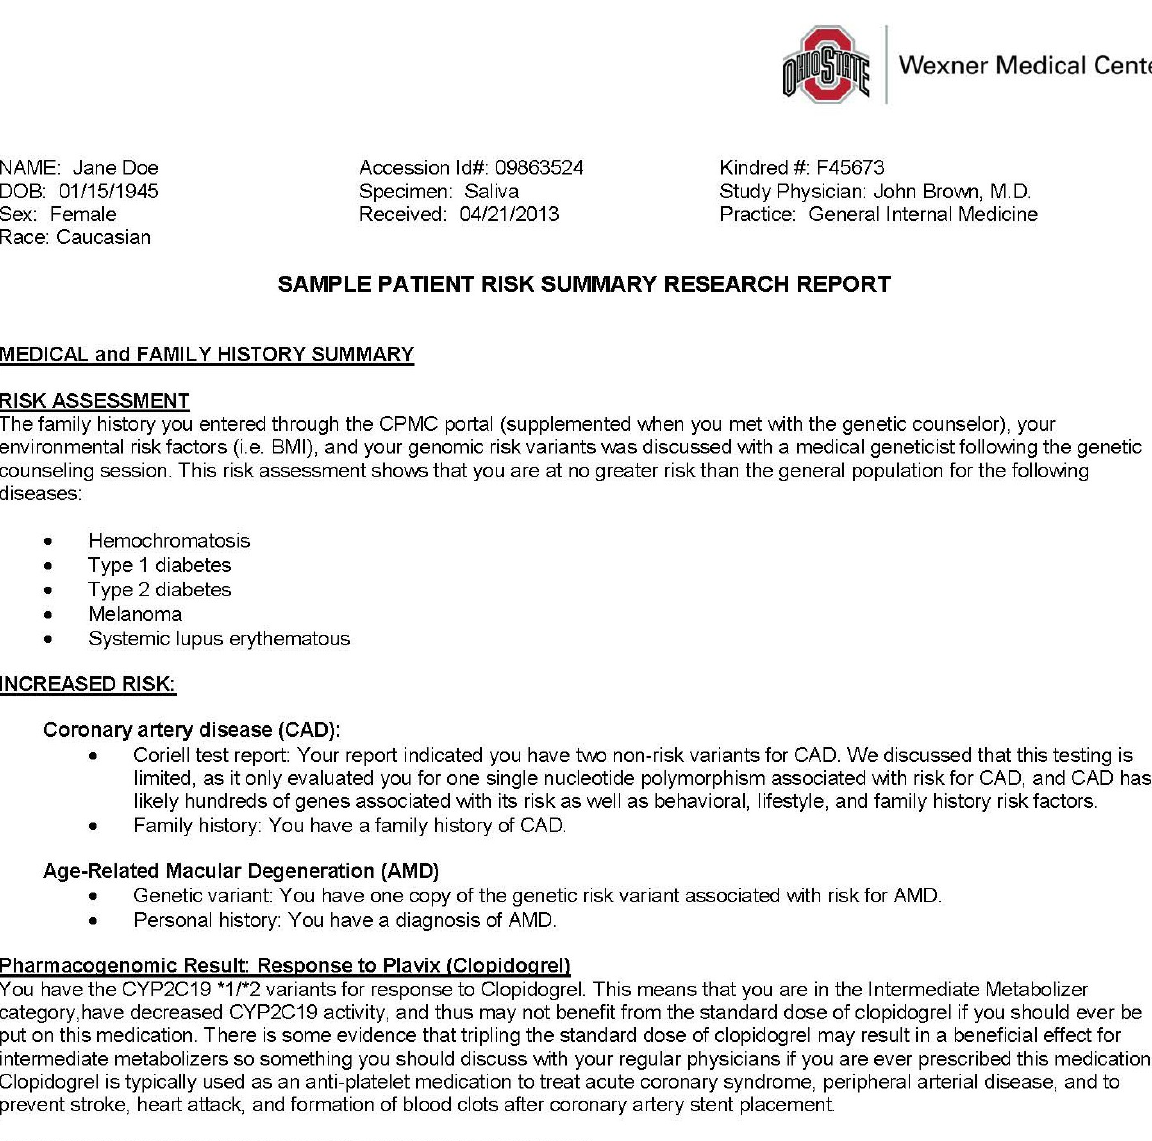
Figure 3. Sample patient risk summary research